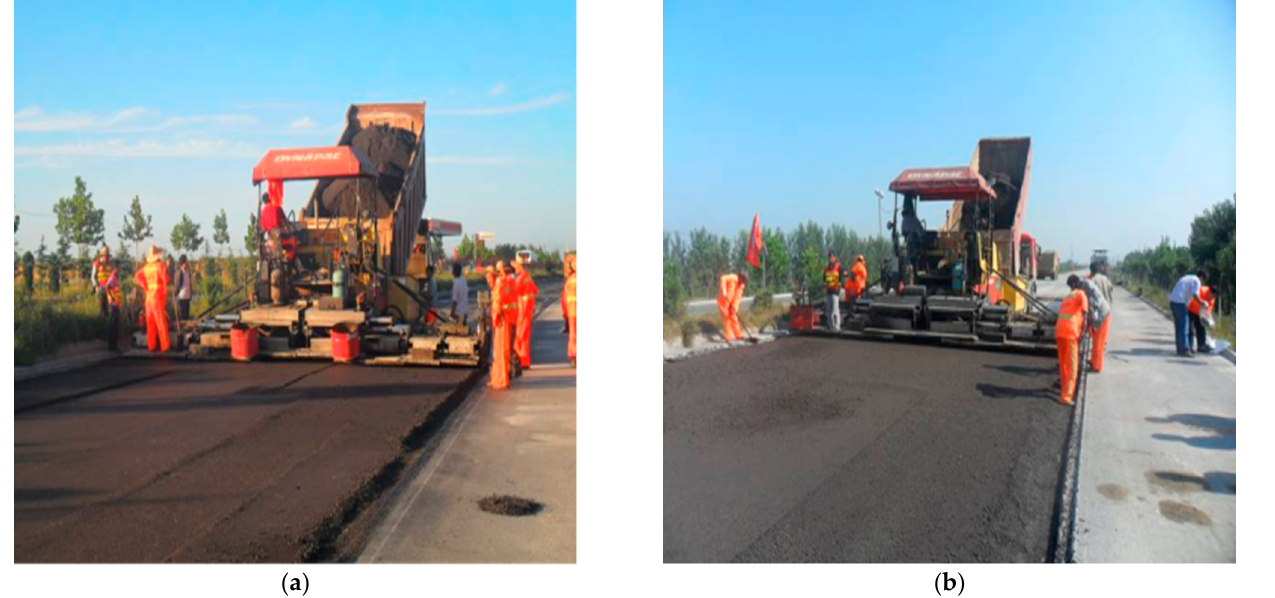
Figure 3. The construction operation of CRM structure test sections. ( a ) In–field construction of emulsified asphalt CRM. ( b ) In–field construction of foamed asphalt CRM.